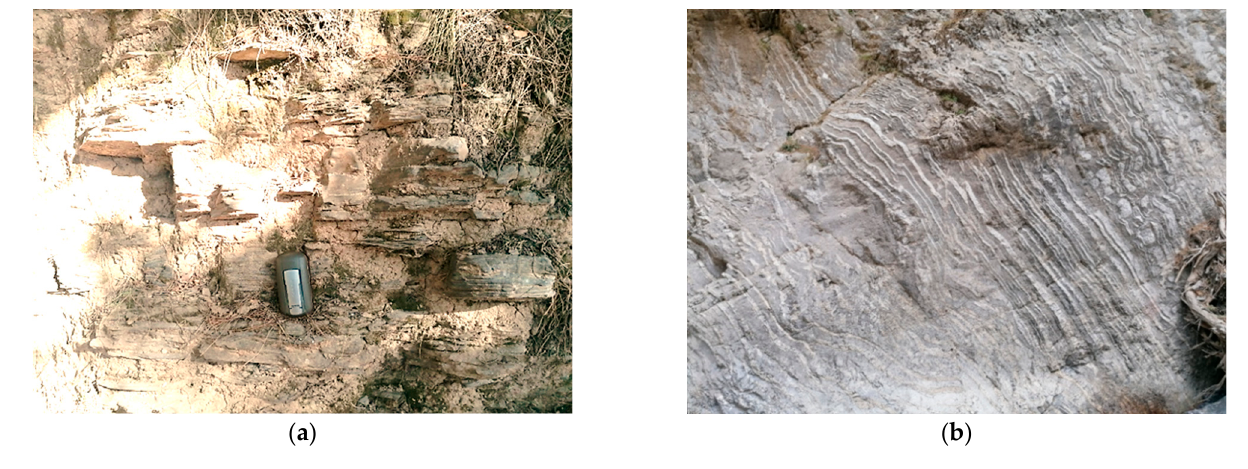
Figure 9. The main lithological formations outcropping in the Samaria Gorge: ( a ) Gigilos formation, consisting of phyllites and slates. The slopes are characterized by smooth dip angles; ( b ) Plattenkalk formation, consisting of recrystallized limestones with chert intercalations, showing steep slopes.